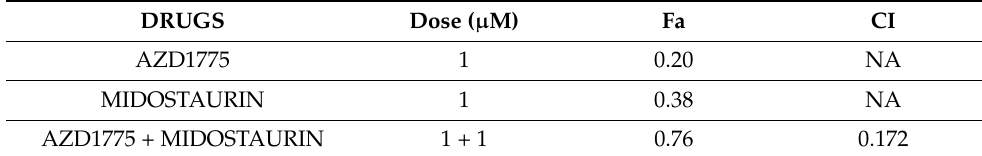
Table 1. HMC-1.1. Effects of WEE1 or KIT inhibition alone or in combination. Data obtained by cytofluorimetric evaluation of apoptotic cell death were analyzed by using a dedicated software (Compusyn) and the combination index (CI) was calculated. Fa is the fraction of cells affected by drugs treatment.